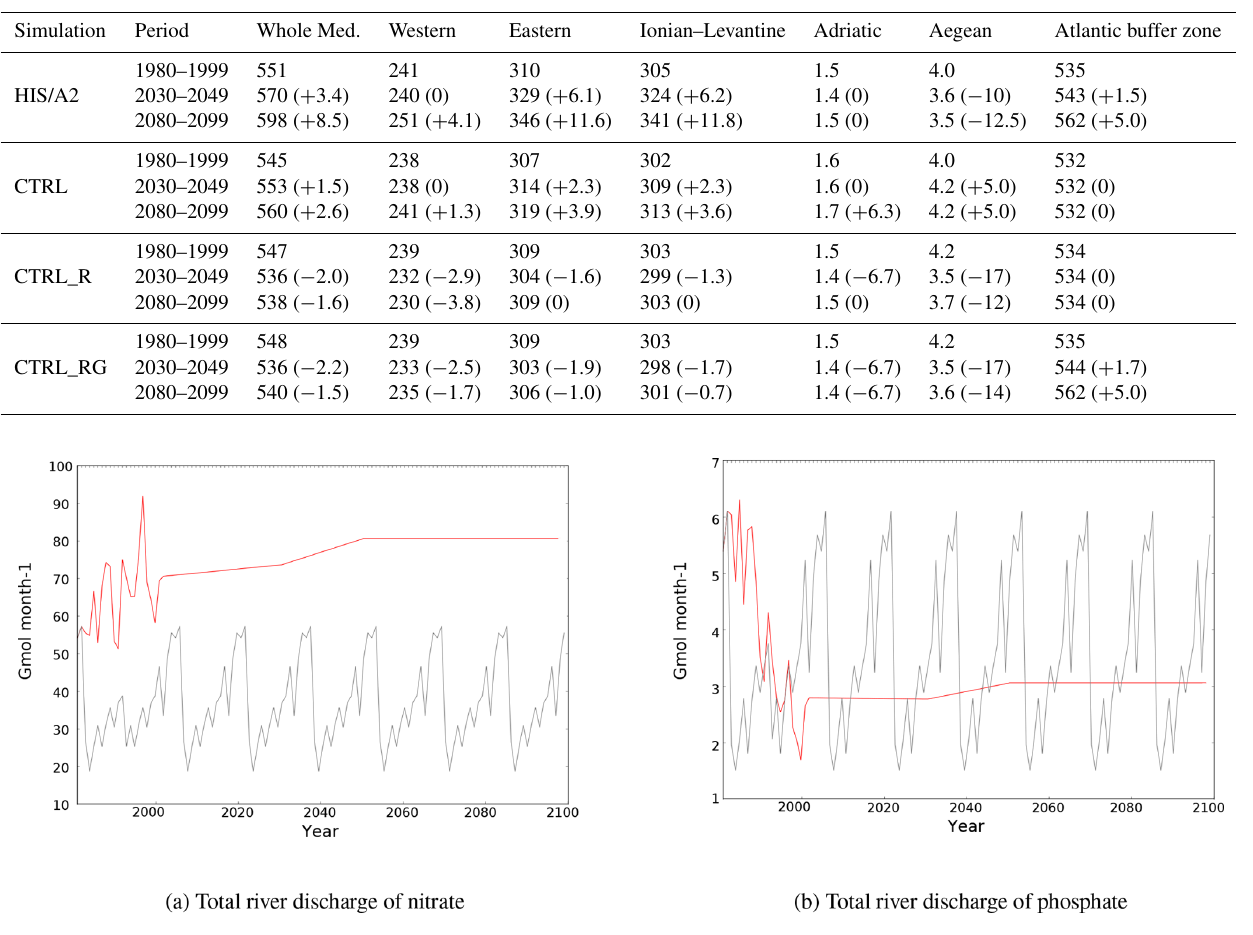
Figure 5. Evolution of total river discharge fluxes of nitrate and phosphate (10 9 molmonth − 1 ) to the Mediterranean Sea in the CTRL (grey) and HIS/A2 (red)